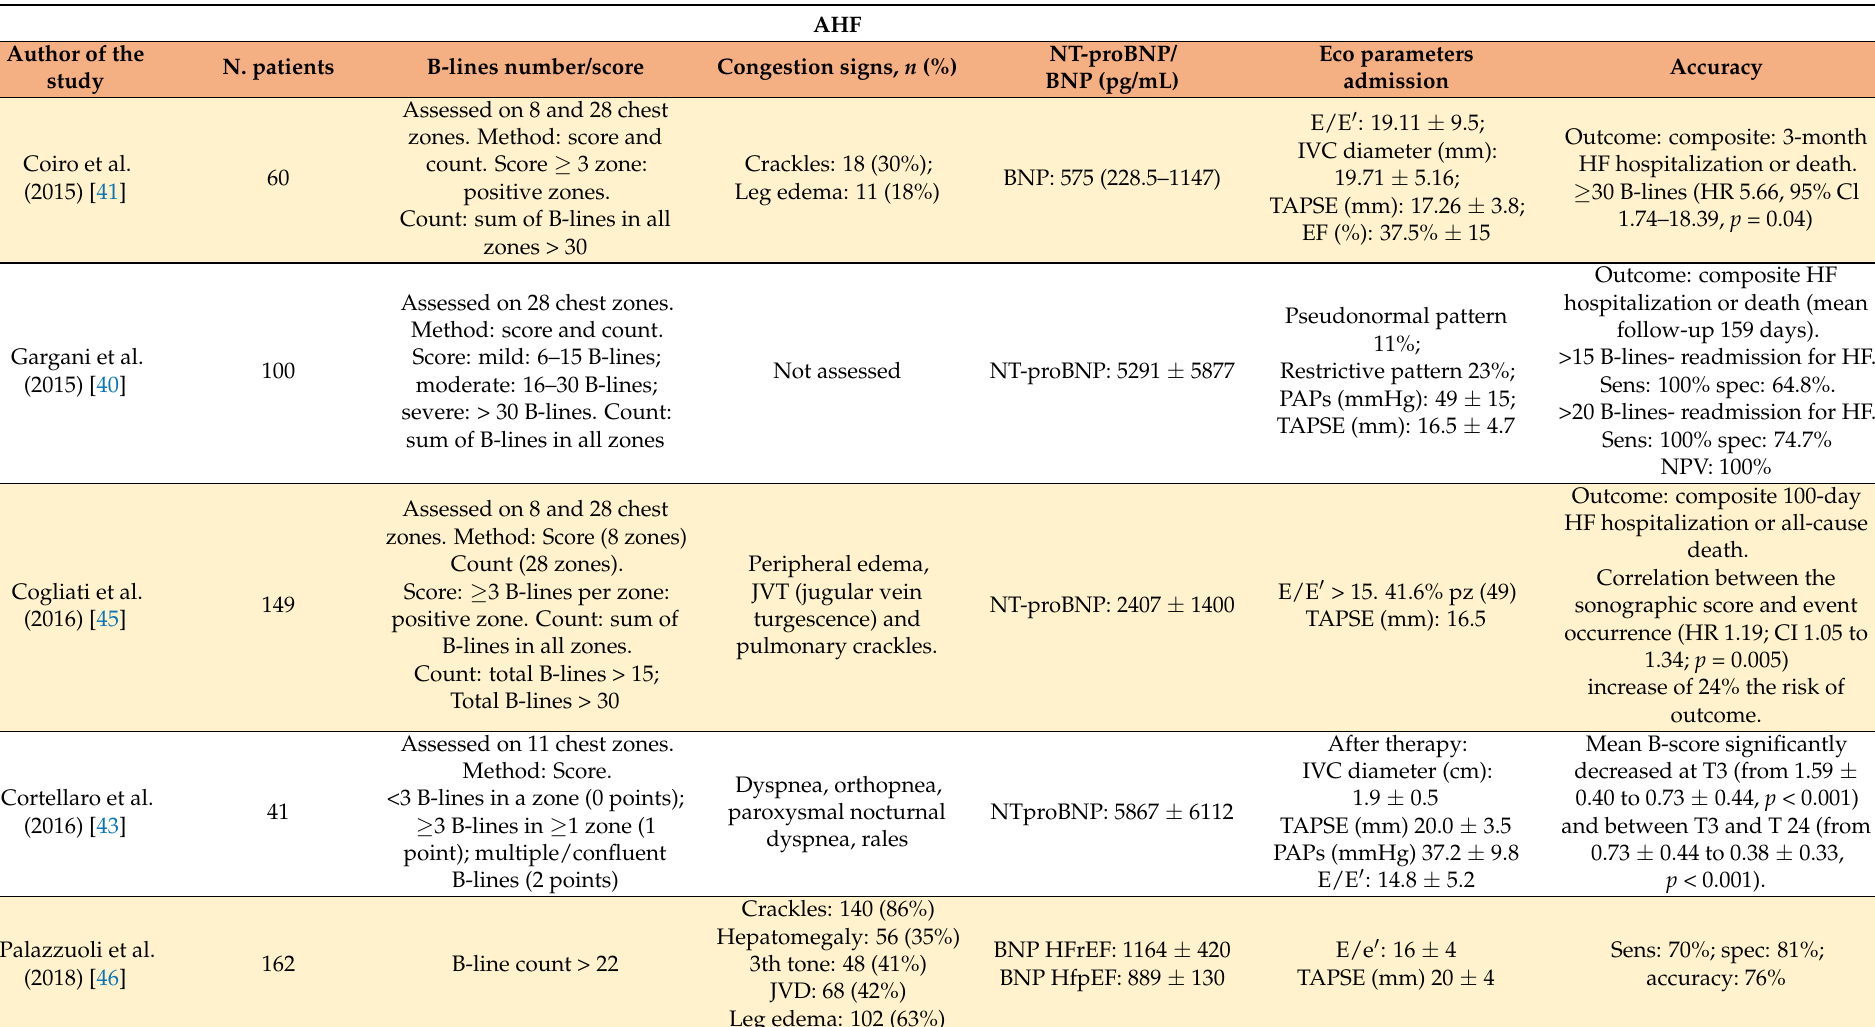
Table 1. Diagnostic accuracy of different LUS analyses in pulmonary congestion evaluations compared with clinical congestion evaluation NPs measurements and relationship with echocardiographic